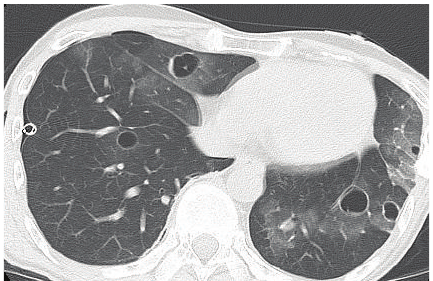
Figure 3: Chest computed tomography taken 9 months after the operation for pulmonary complications shows bilateral thin-walled cystic lesions that are surrounded by ground glass opacities, for which the patient underwent placement of a drainage tube in the pleural space for right